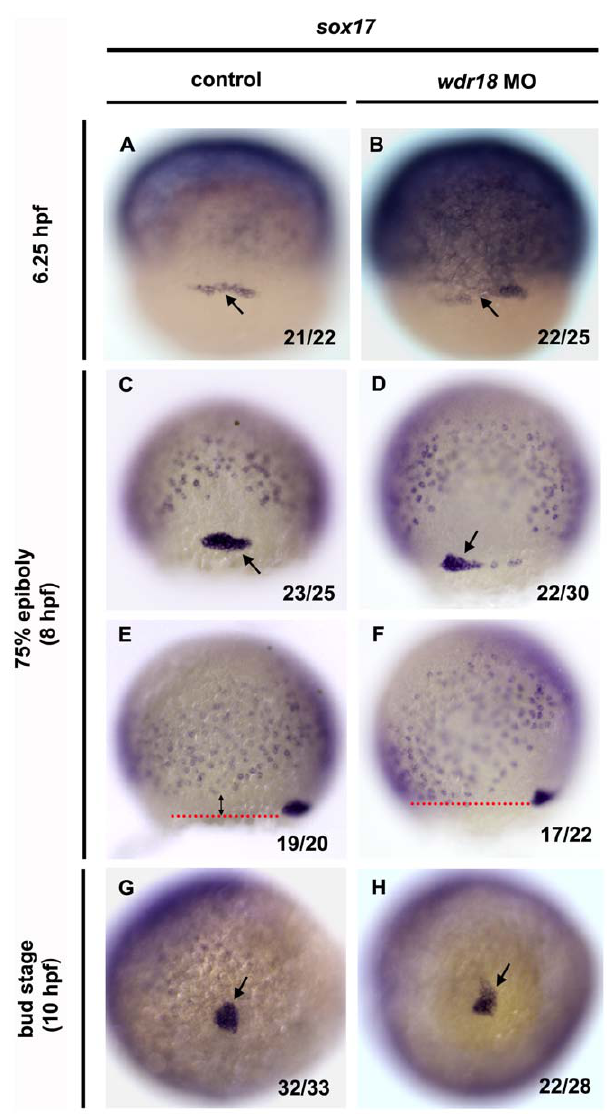
Figure 6. DFC migration is affected in wdr18 morphant embryos. (A–H) In situ hybridization with sox17 showing the migration and clustering process of DFCs in control and wdr18 morphant embryos at 6.25 hpf, 75%-epiboly stage and bud stage. sox17 is a marker of endodermal cells and DFCs. The pepper-like staining represents endoder- mal cells and the grouped cells (black arrow) indicate DFCs. (A, C, G) The DFCs in control embryos first appeared as a horizontal line of cells (A), and then migrated toward the vegetal pole while forming a compact oval- shaped cluster (C) and eventually a round condensed cell mass at the end ofepiboly,whichwill gradually differentiateintothe Kupffer’s vesicle. (B, D, H) In wdr18 morphant embryos, the shape of DFCs looked nearly the same as control embryos at 6.25 hpf (B), however, the DFCs failed to form a single compact cell cluster at 75%-epiboly stage (D). Although the DFCs in morphant embryos could finish clustering process at the end of epiboly, the cell mass was frequently appeared misshaped (H). (E, F) The location of the DFCs relative to the endodermal cell layer. (E) In a control embryo, the DFC migratory front (red dotted line) is further ahead of the endodermal cell layer as a result of DFC migration towards the vegetal pole. (F) In the morphant embryo, the DFC migratory front is almost at the same level as the endodermal layer, indicating that DFC migration is slower and uncoupled with overall gastrulation movements. The ratio shown in the lower right corner of each image indicate the number of defective embryos versus total embryos. (A–D) Dorsal views, animal pole to the top. (E, F) Side views, dorsal to the right, animal pole to the top.